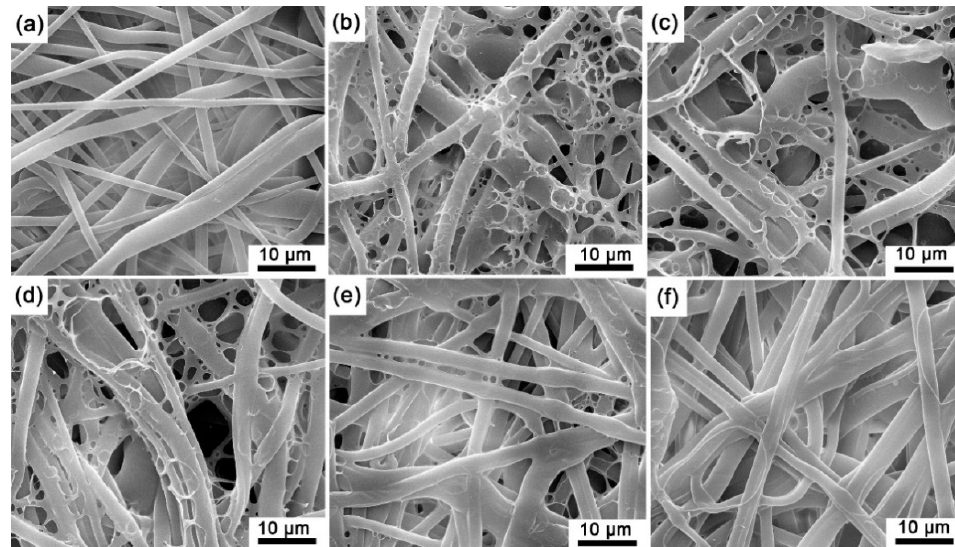
Figure 5. SEM images of ( a ) polypropylene microporous membrane; ( b ) SF-EC; ( c ) SF-E3P1 (EC/PMMA ratio of 3:1); ( d ) SF-E1P1 (EC/PMMA ratio of 1:1); ( e ) SF-E1P3 (EC/PMMA ratio of 1:3); ( f ) SF-PMMA.